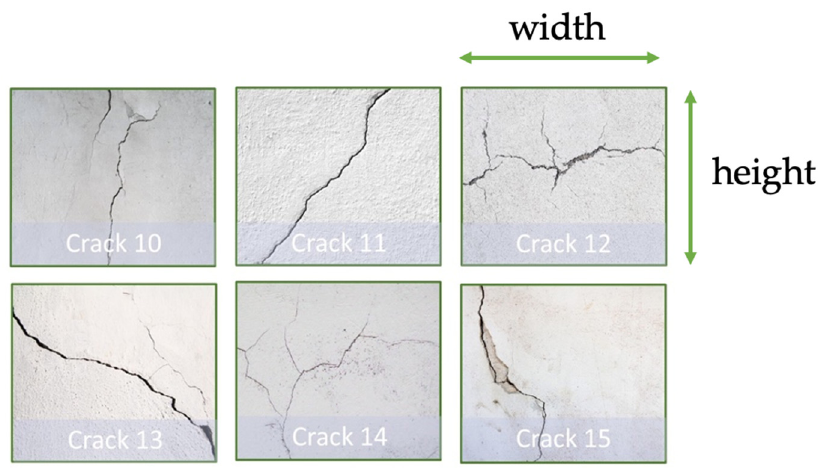
Figure 6. Unseen cracks to test the generalization ability.